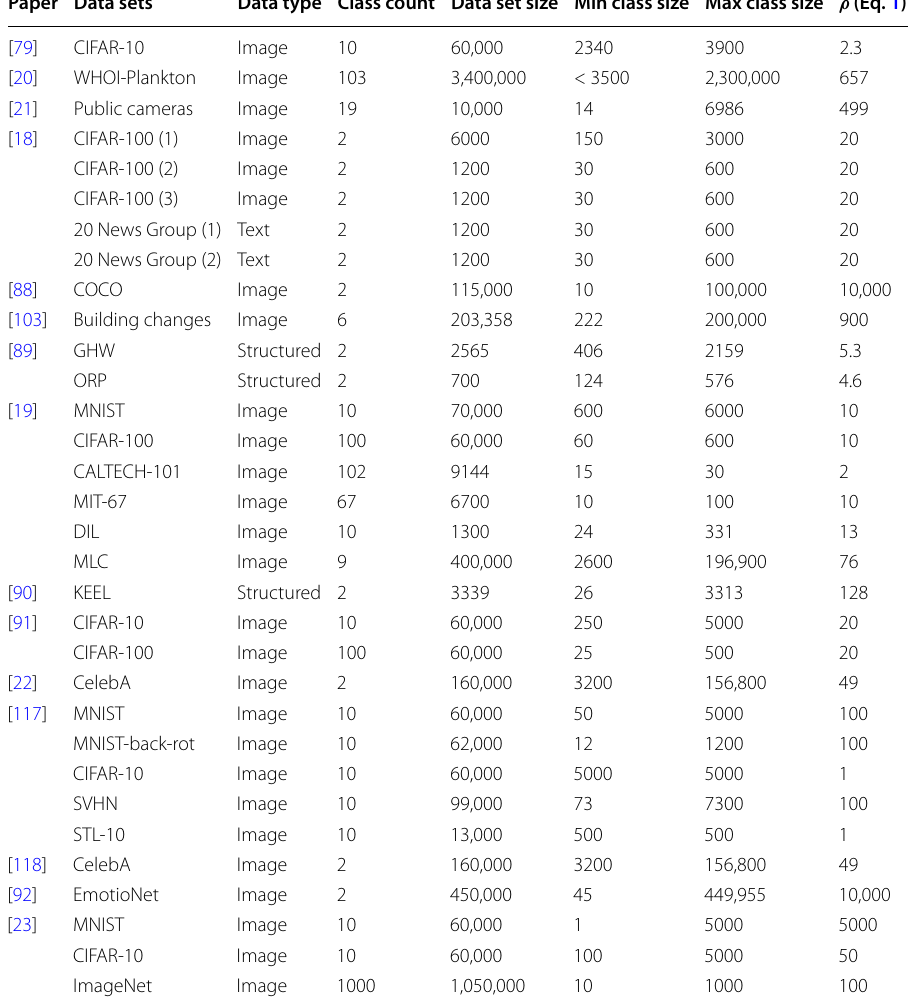
Table 18 Summary of data sets and class imbalance levels Paper Data